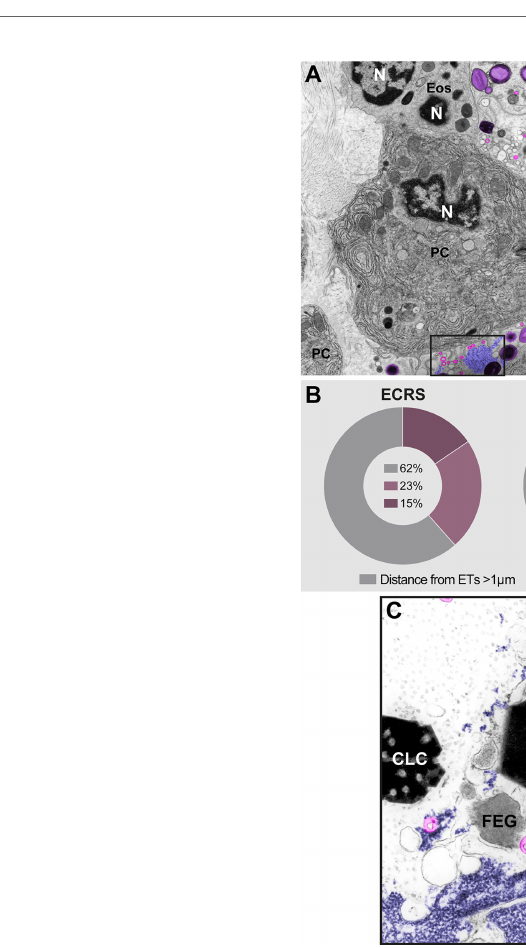
FIGURE 8 | Free-extracellular granules (FEGs), free tubular carriers [eosinophil sombrero vesicles (EoSVs)], and Charcot-Leyden crystals (CLCs) are associated with late ETosis (A) An in fl amed tissue site (nasal sinus) from a patient with eosinophilic chronic rhinosinusitis (ECRS) shows an ETotic eosinophil with decondensed chromatin (colored in purple) spreading in the extracellular matrix. Note intact secretory granules (light purple) and intact free EoSVs (pink) spread around and in contact with extruded chromatin. The boxed areas in (A) are shown in higher magni fi cation in (Ai, Aii) . Arrowheads point to typical EoSVs. In (Ai) , an EoSVs associates with an intact granule. (B) Quantitative TEM of in fl ammatory tissue sites from all eosinophil-associated diseases (EADs) showed that intact EoSVs are found in direct contact with or close to (<1μm of distance) extruded chromatin, or spread (>1μm of distance from DNA strings) in the tissue area. A total of 744 free EoSVs [335 for ECRS, 181 for ulcerative colitis (UC), and 228 for hypereosinophilic syndrome (HES)] were evaluated in electron micrographs considering only late EETosis. (C) CLCs, free EoSVs (pink) and FEGs are enmeshed in tissue chromatin deposits (purple) in a tissue biopsy (nasal sinus) from an ECRS patient. Samples were prepared for